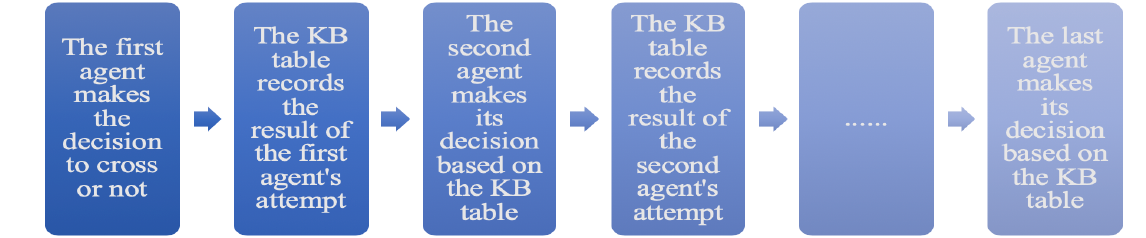
Figure 1. An illustration of the update of the KB table in the